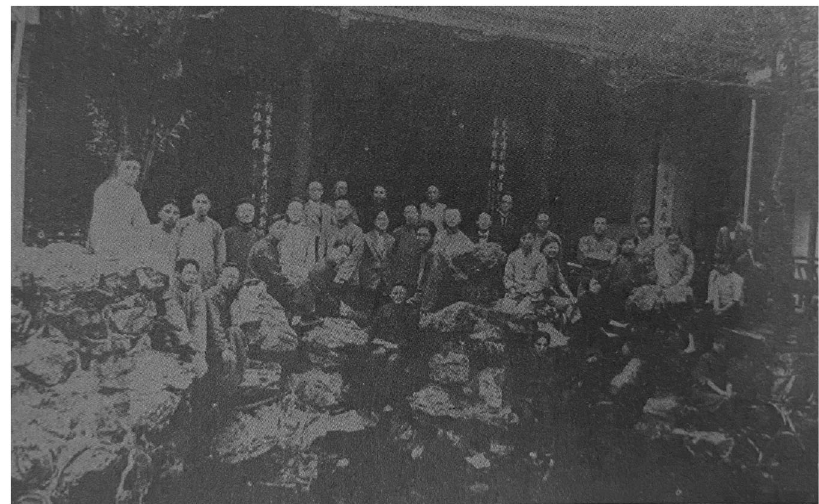
Fig. 2 A group photo of participating members of the Jiangsu Provincial Education College at the joint conference. In 1935, the experimental joint conference of Jiangsu Provincial Education College was held in Huishan Park. The main content of the conference was to discuss and solve the problems encountered in popular education and carry out new research and design on popular education.